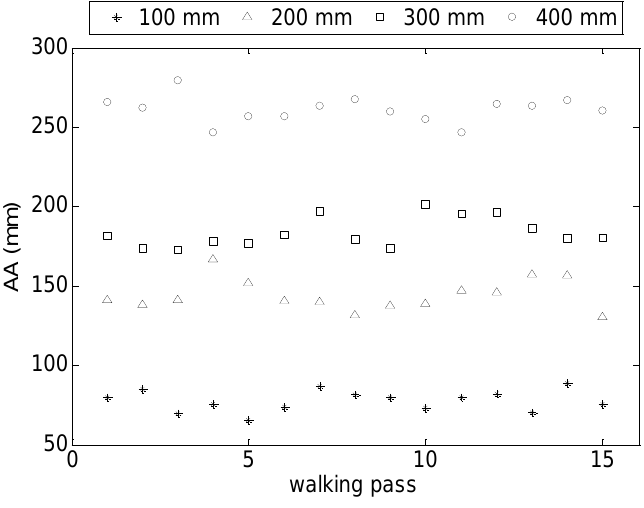
Figure 11. Individual values of the AA parameter: One period